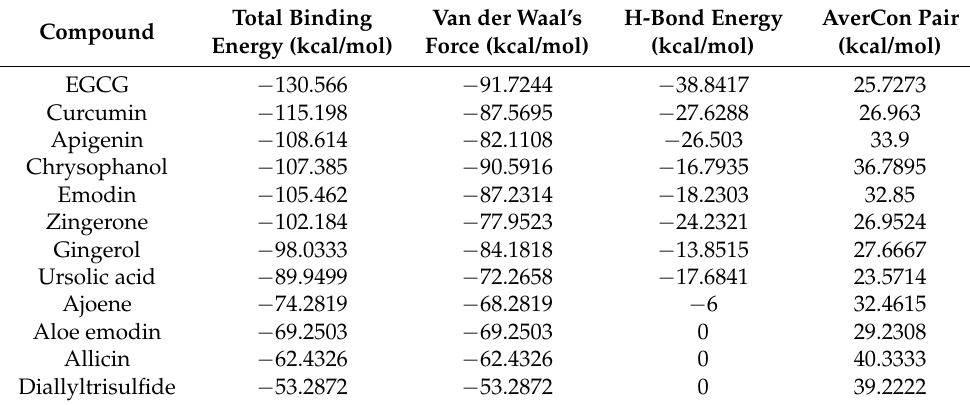
Table 1. Binding energy between polyphenols and SARS-COV-2 spike